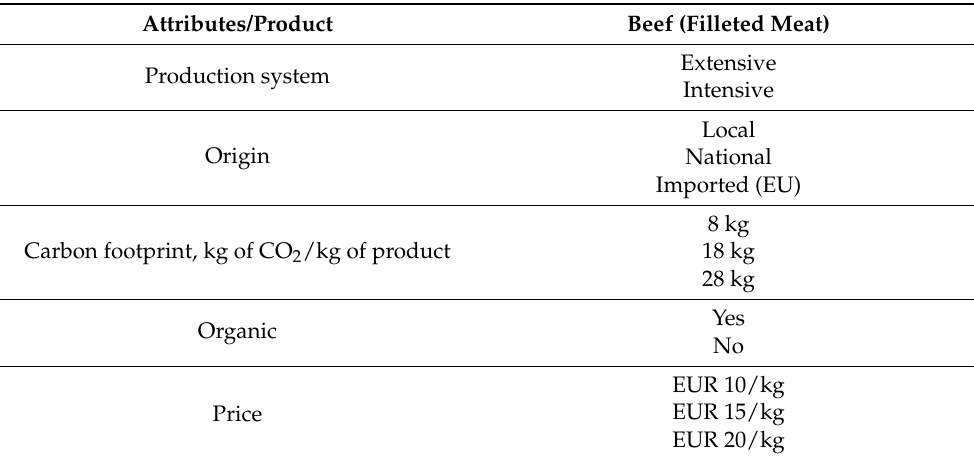
Table 2. Selected